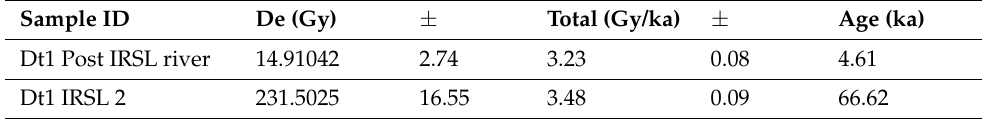
Figure 10. Radiocarbon dates were calibrated by OxCal 4.3.2 calibration program (Bronk Ramsey 2017) using atmospheric IntCal13 calibration curve (Reimer et al. 2013) (DT1: trench one, C: sample carbon). Table 2. Values used to calculate luminescence ages (OSL).